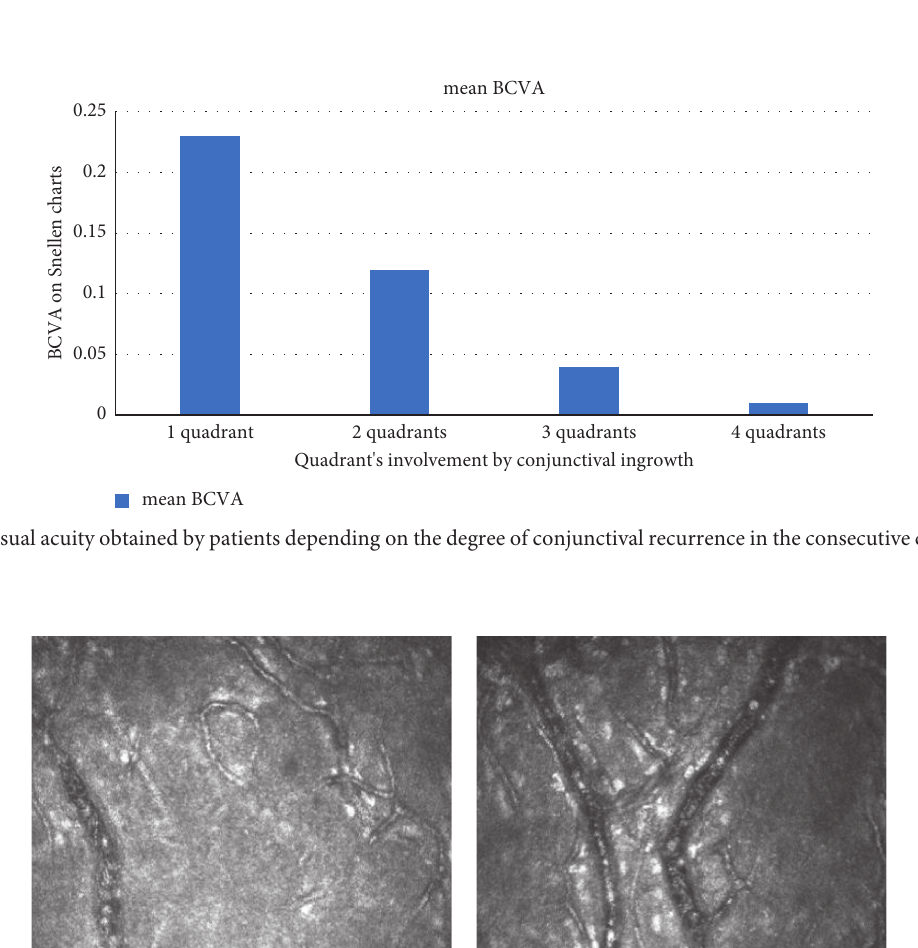
Figure 4: Average of clock hours of conjunctival invasion in failure group over 120 months.